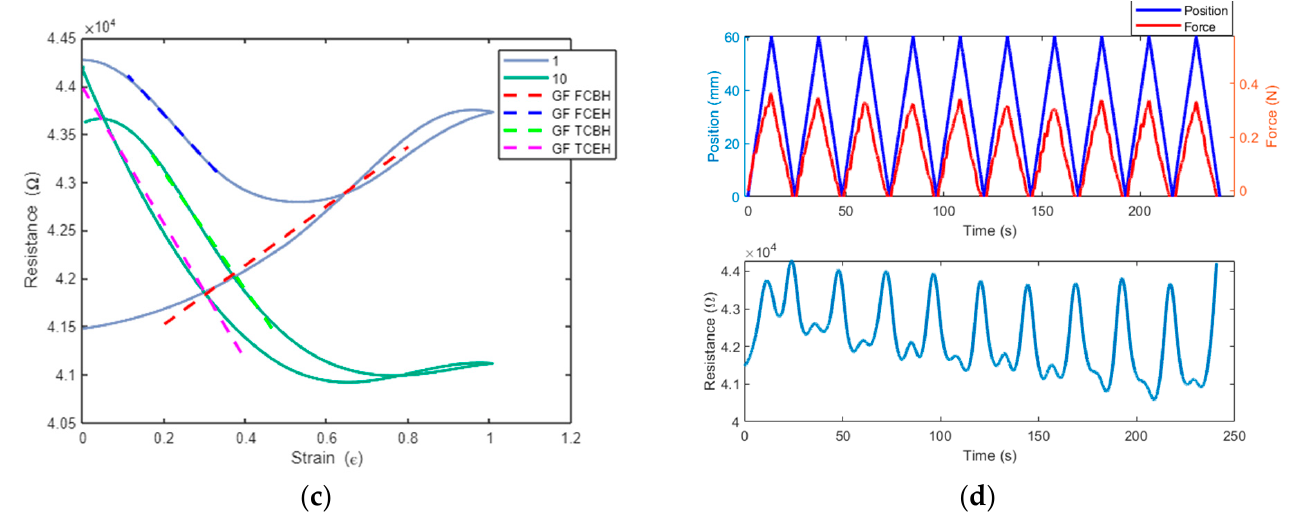
Figure 18. KH cyclic tensile test results: (a) Resistance vs. strain for ten cycles. (b) Stress vs. strain for ten cycles. (c) Resistance vs. strain and gauge factors for the first and the tenth cycles. (d) Displacement, force, and resistance change over time for ten cycles.